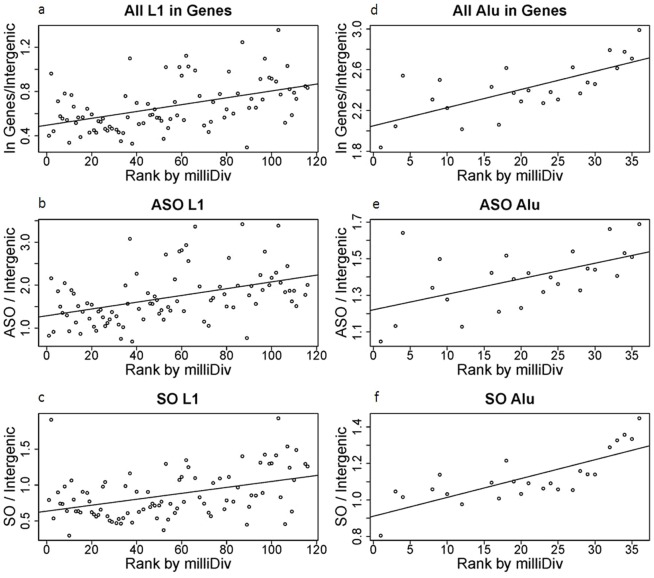
Alu and L1 densities increase in genes over time.Densities were calculated per subfamily as bp repeat element per bp region normalized by calculations for the same subfamily intergenically. Groups were divided into: All L1 within genes (a), antisense oriented L1 in genes (ASO L1) (b), sense oriented L1 in genes (SO L1) (c), all Alu within genes (d), antisense oriented Alu in genes (ASO Alu) (e), and sense oriented Alu in genes (SO Alu) (f). Subfamilies were then ranked based on their average base mismatches from consensus in parts per thousand (milliDiv) with an increase in milliDiv indicating a higher divergence, and therefore larger numbered rank (see Dataset S2). Results were plotted as an increase of this subfamily rank. The resulting slopes of density over subfamily rank were: 0.003all L1, 0.008L1 ASO, 0.004SO L1, 0.018all Alu, 0.008Alu ASO, and 0.010Alu SO.